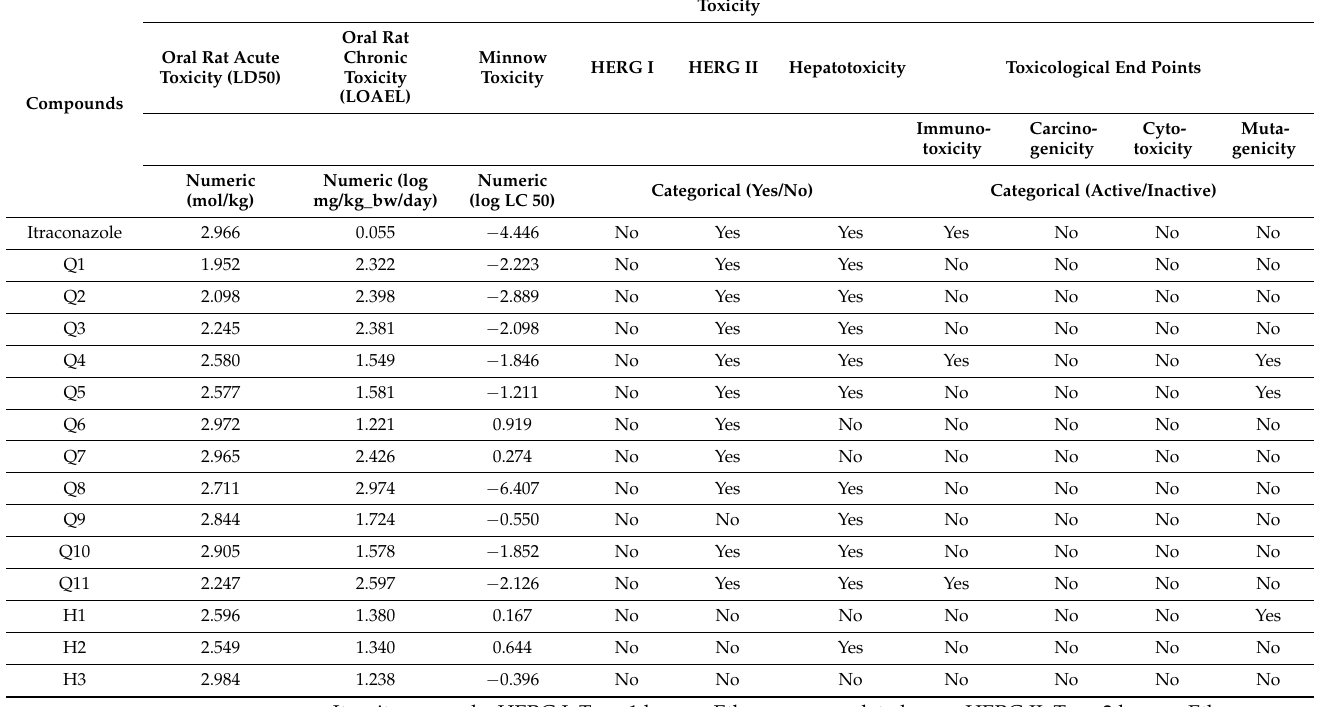
Table 5. Toxicological in silico profile of synthetic